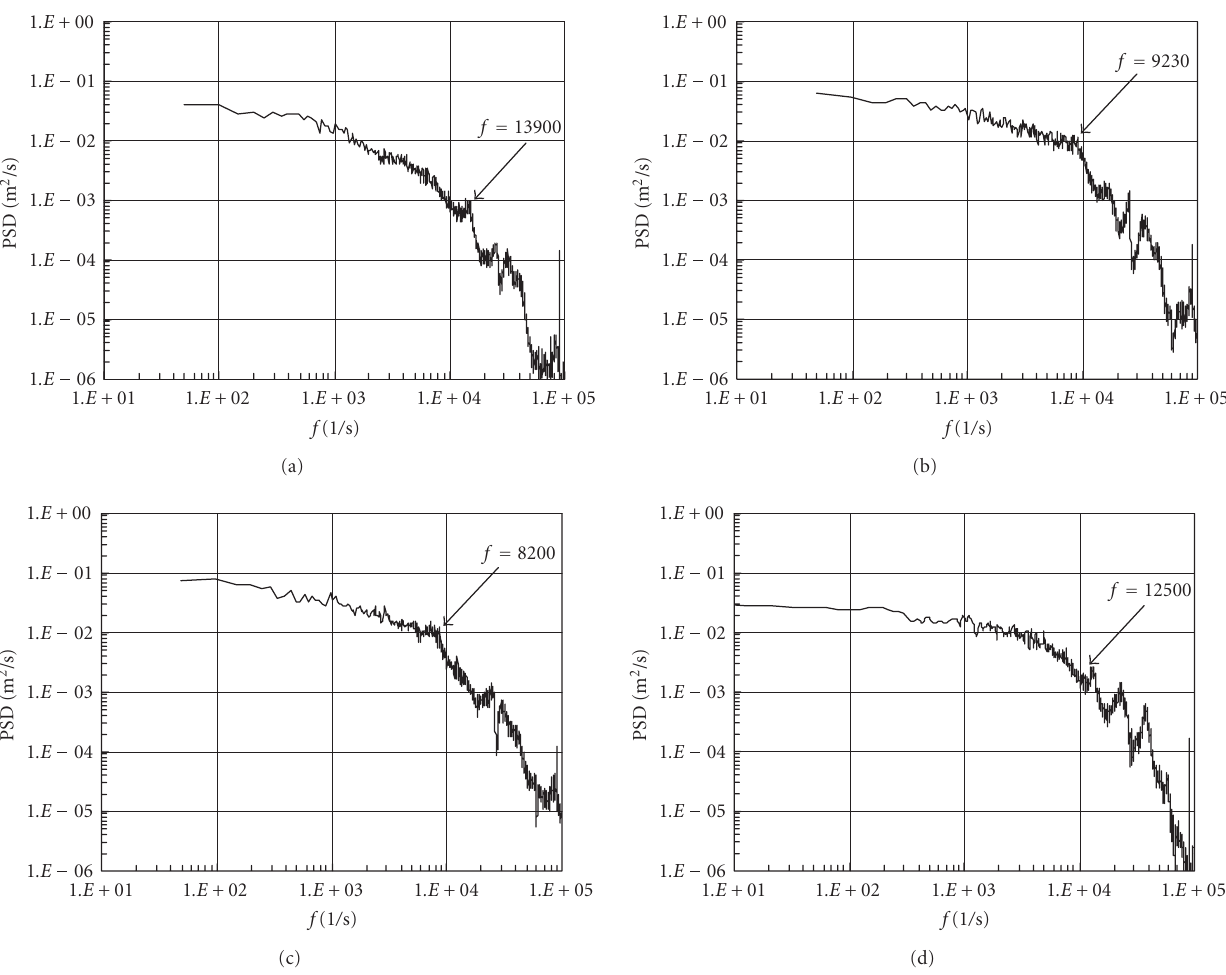
Figure 9: Power spectra density profiles measured in the pressure side wake at y/cx = 0 . 10 one axial chord length downstream of the cambered airfoils for Tu = 5 . 4 percent. (a) Smooth airfoil, ks/cx = 0. (b) Airfoil with small-sized roughness, ks/cx = 0 . 00108. (c) Airfoil with big-sized roughness, ks/cx = 0 . 00258. (d) Airfoil with variable